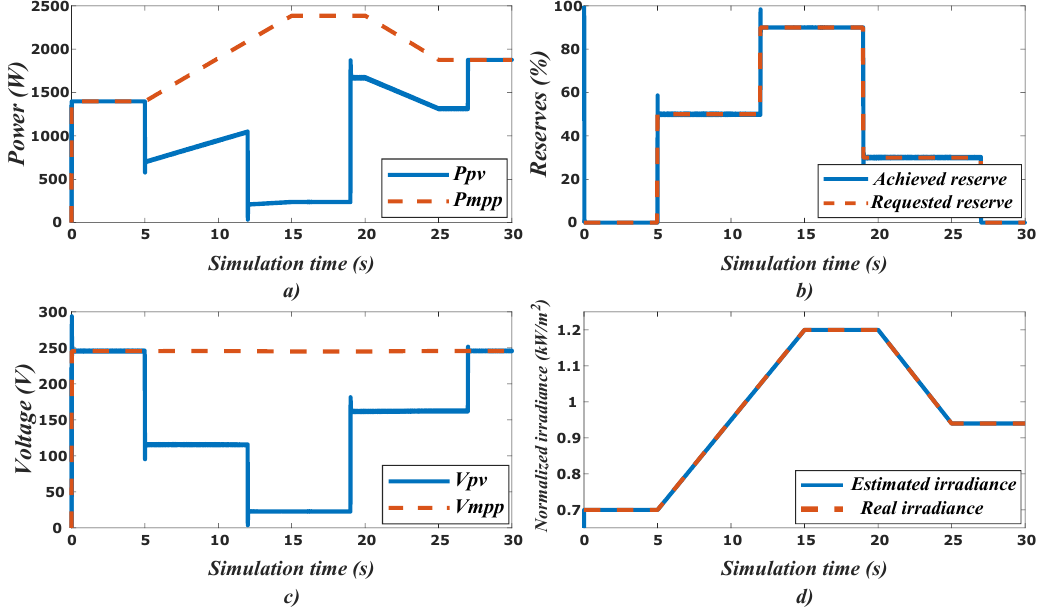
Figure 15. Case Study #2: ( a ) Power evolution, ( b ) Reserves evolution, ( c ) Voltage evolution and ( d ) Normalized irradiance